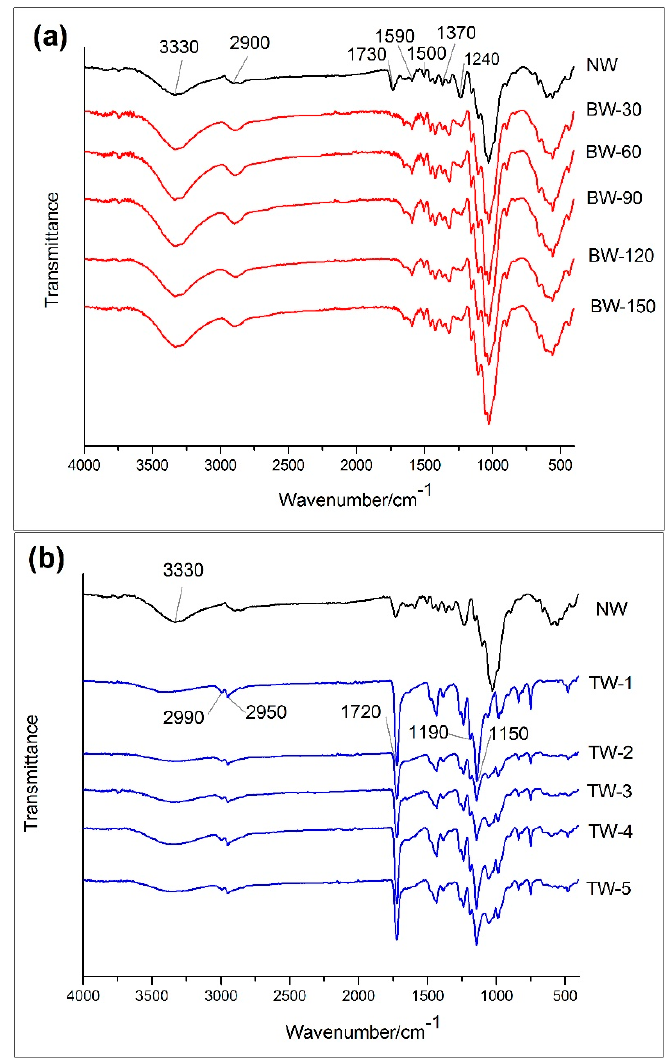
Figure 3. ( a ) FTIR spectra for natural wood (NW) and bleached wood (BW) samples. ( b ) FTIR spectra for natural wood (NW) and transparent wood (TW) samples. 221